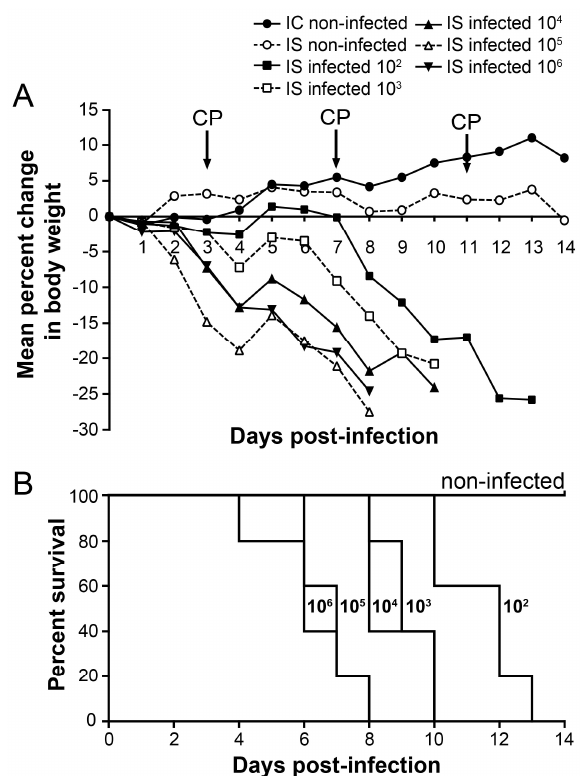
Figure 1. Weight loss ( A ) and survival rate ( B ) of IS C57BL/6 mice intranasally infected with 10 2 to 10 6 TCID 50 of rec A(H1N1)pdm09 in 30 µL of PBS. Animals were monitored daily for 14 days for clinical 20% of their original body